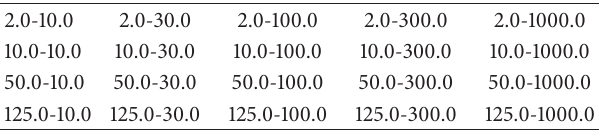
Table 1: Expected Tg and TgAb concentrations of twenty experi- mental samples produced with standard solutions of Tg and TgAb. Values are expressed as Tg (ng/mL)-TgAb (U/mL).